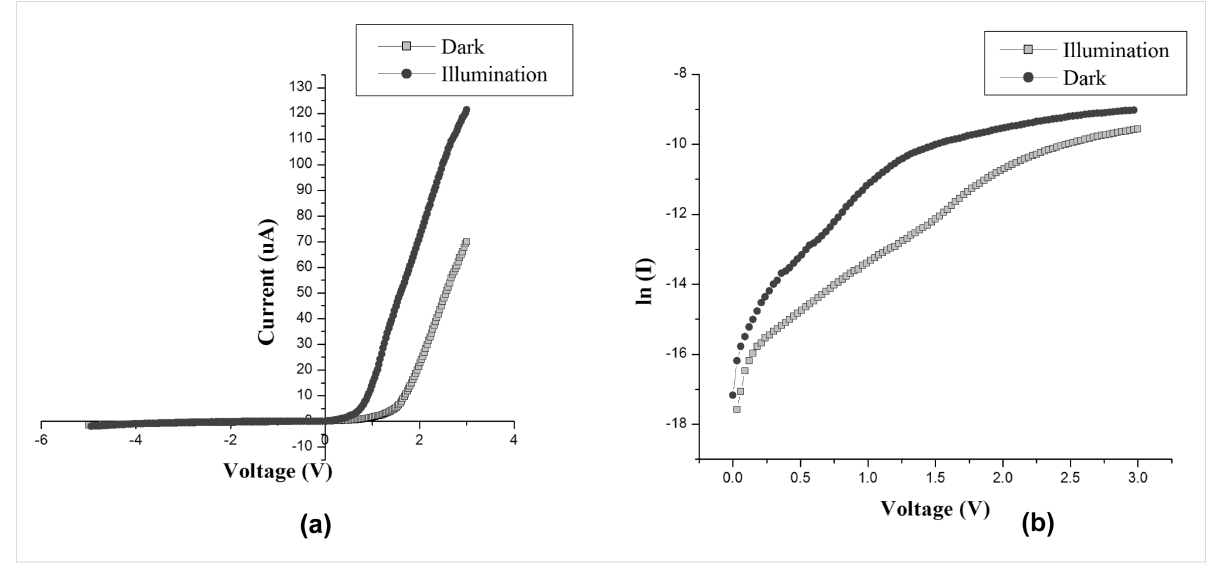
Figure 2: (a) I–V characteristics of the diode under dark and UV illumination and (b) ln I vs V curve under dark and UV